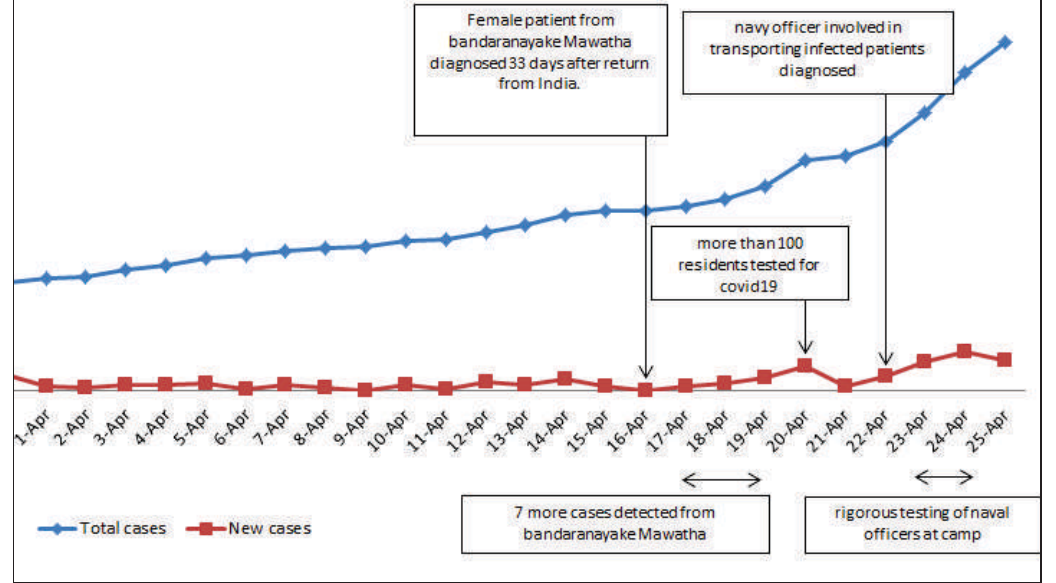
Figure 6: The timing of two incidents and the aftermath which led to the rise of reported cases